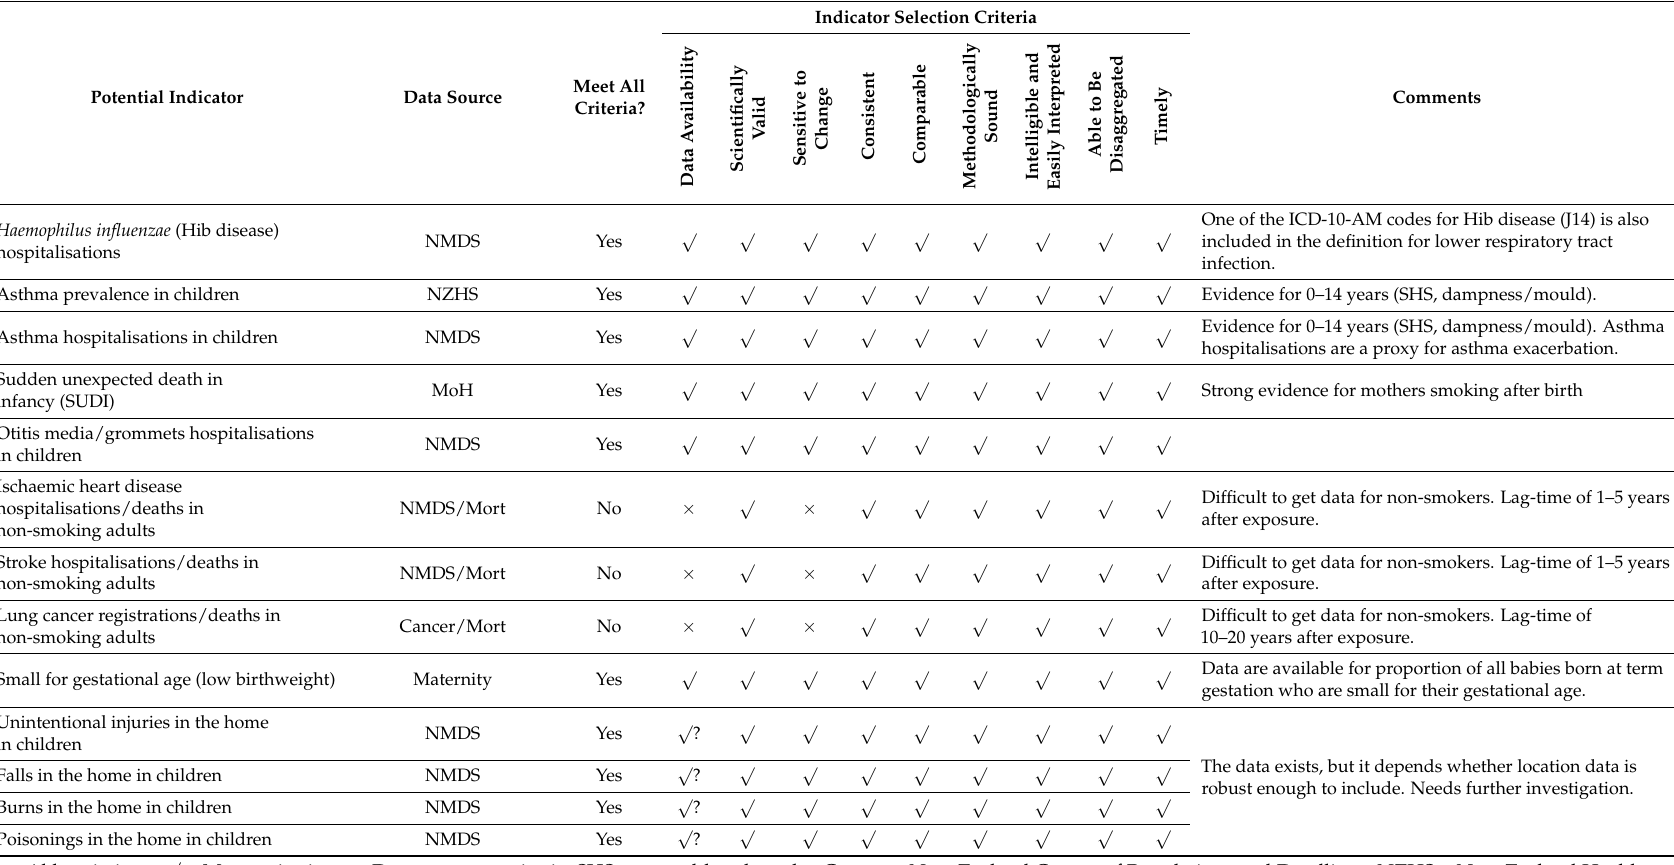
√ √ √ √ √ √ √ √ Abbreviations: = Meets criteria; × = Does not meet criteria; SHS = second-hand smoke; Census = New Zealand Census of Populations and Dwellings; NZHS = New Zealand Health Survey; Maternity = New Zealand Maternity Clinical Indicators; NZGSS = New Zealand General Social Survey; EpiSurv = EpiSurv notifiable disease surveillance database; MoH = Ministry of Health publications; NMDS = National Minimum Dataset (hospitalisations data); Mort = New Zealand Mortality Collection; Cancer = New Zealand Cancer Registry; ICD-10-AM = International Statistical Classification of Diseases and Related Health Problems, Tenth Revision, Australian